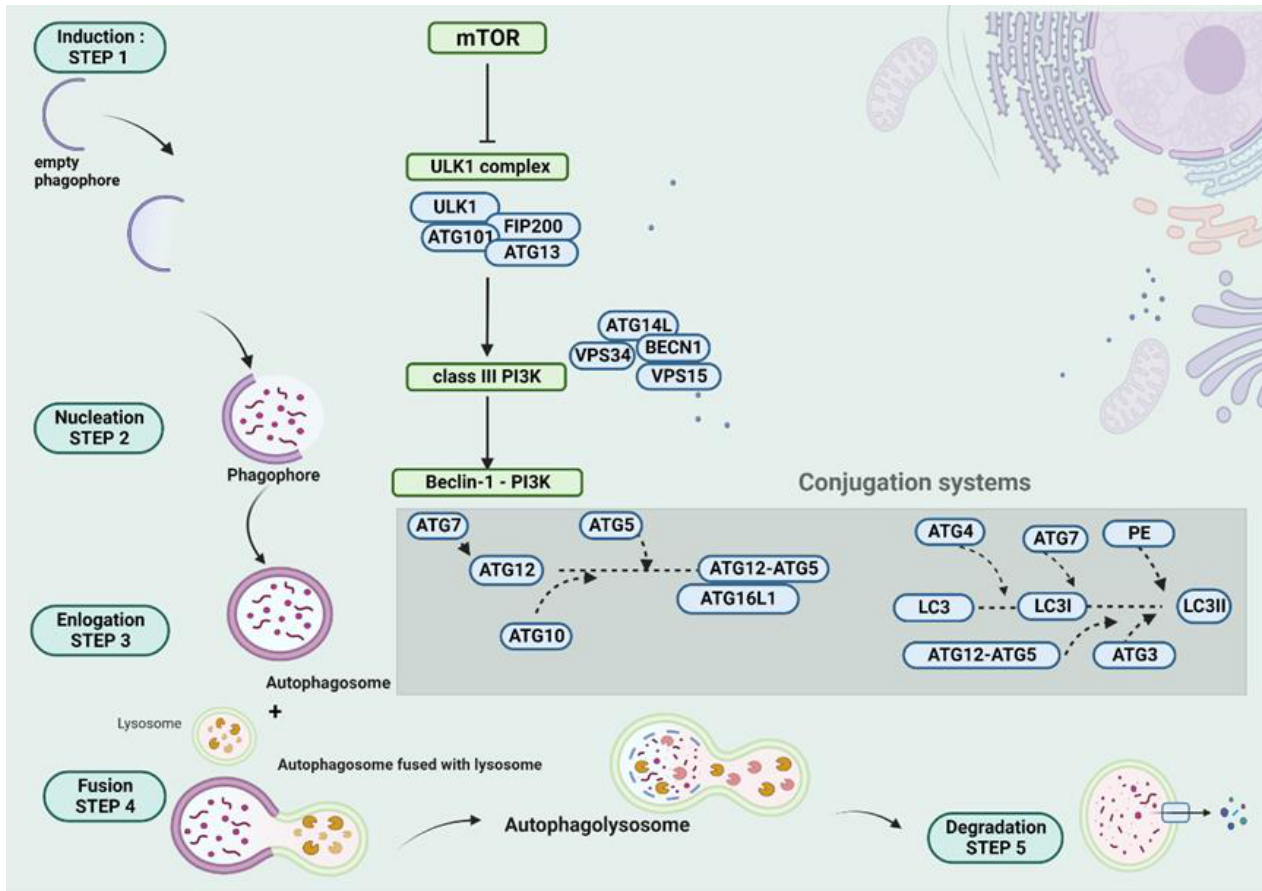
Figure 1. A schematic presentation of the autophagy steps. The autophagy pathway is inducted via the inhibition of mTOR, which is dissociated from ULK1. The second step of nucleation of ULK1 activates the class III PI3K, with the formation of the Beclin-1-PI3K complex. The third step includes the elongation of the phagophore and the formation of autophagosome. Two conjugations take place at that level, between ATG12 and ATG5, as well as LC3I and PE. The fourth and the fifth step include the fusion of lysosome with autophagosome, resulting in an autophagolysosome and the degradation of cargoes, respectively. This figure was created with “BioRender.com” accessed on 24 August 2022. (Agreement number